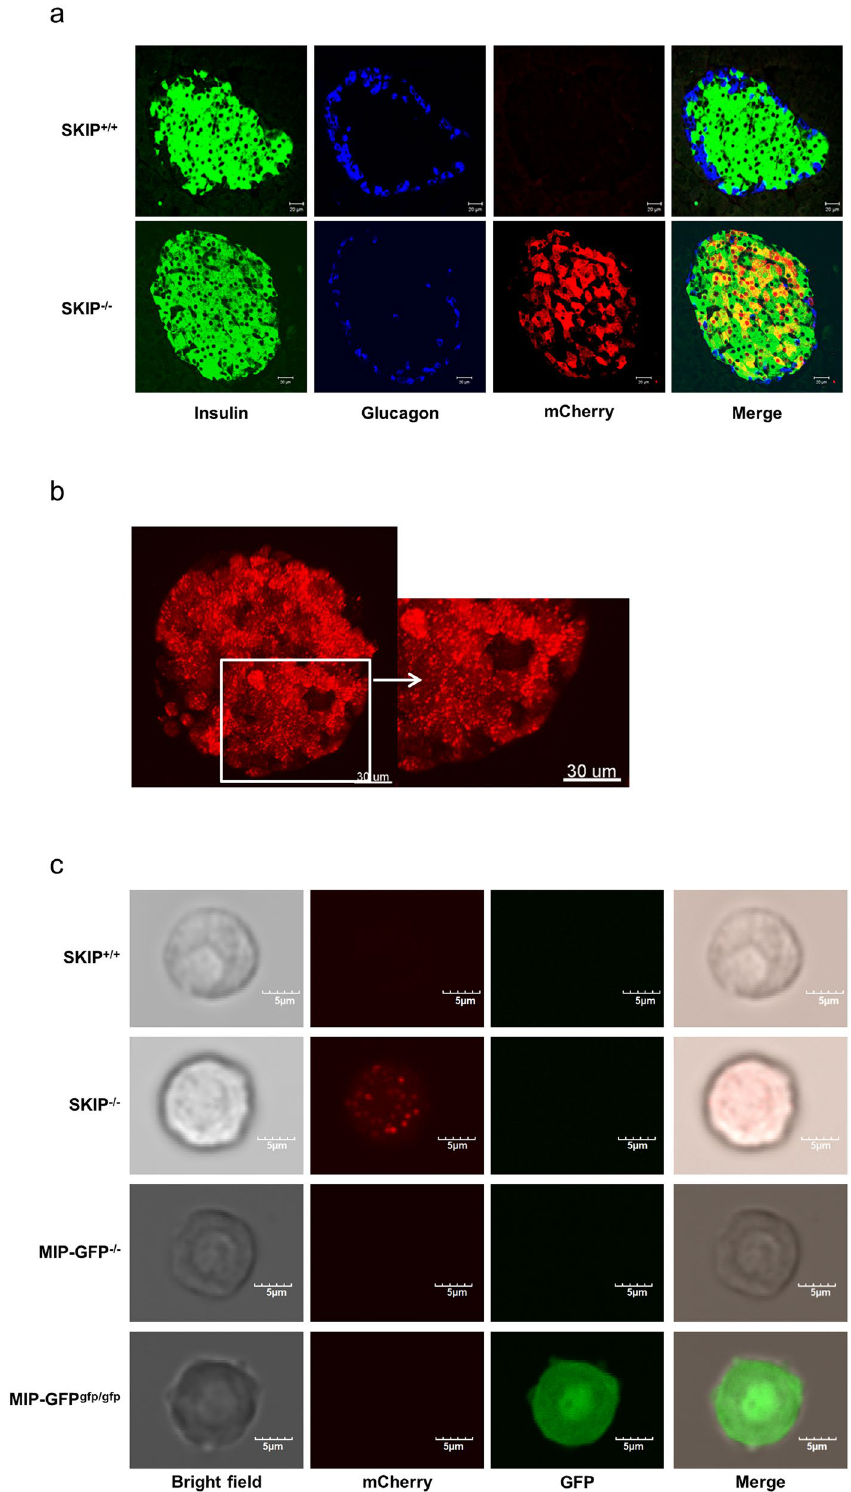
Figure 3. Localization of SKIP in the islets. ( a ) Immunohistochemical images in the pancreas from SKIP − / − mice and SKIP + / + mice; green, anti-insulin; blue: anti-glucagon; and red, anti-mCherry. ( b ) 3D imaging by incubator two-photon microscopy in isolated islets from SKIP − / − mice. ( c ) Incubator two-photon excitation microscopy images of living β -cells from SKIP − / − (SKIP-mCherry KI) mice and MIP-GFP mice; left column, bright field; second column, mCherry; third column, GFP; right column, merged images. 12-week-old mice were used for the experiments, n =